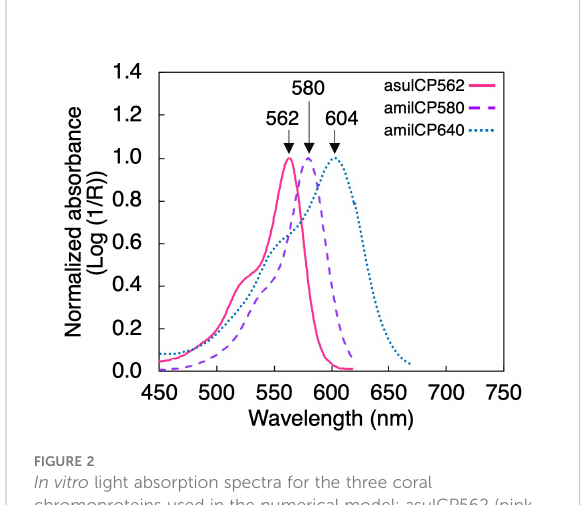
FIGURE 2 In vitro light absorption spectra for the three coral chromoproteins used in the numerical model: asulCP562 (pink solid line), amilCP580 (purple dashed line), and amilCP604 (blue dotted line) extracted from coral tissue (after Smith et al.,